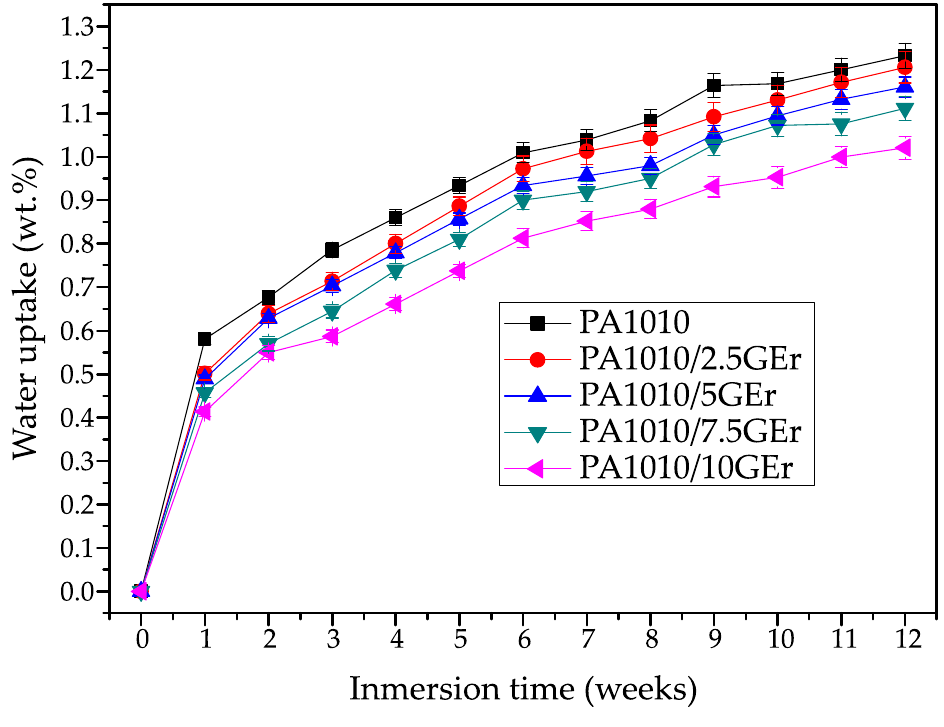
Figure 8. Water uptake of PA1010/EGr composites.